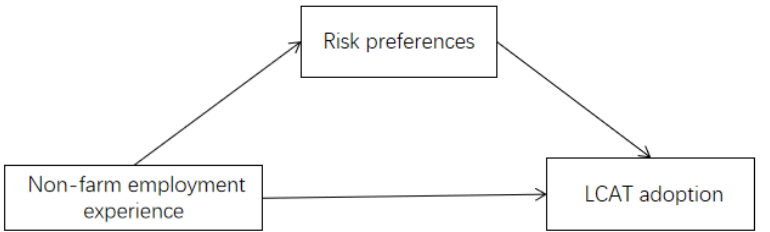
Figure 1. The mechanism of how non-farm employment experience affects LCAT adoption.